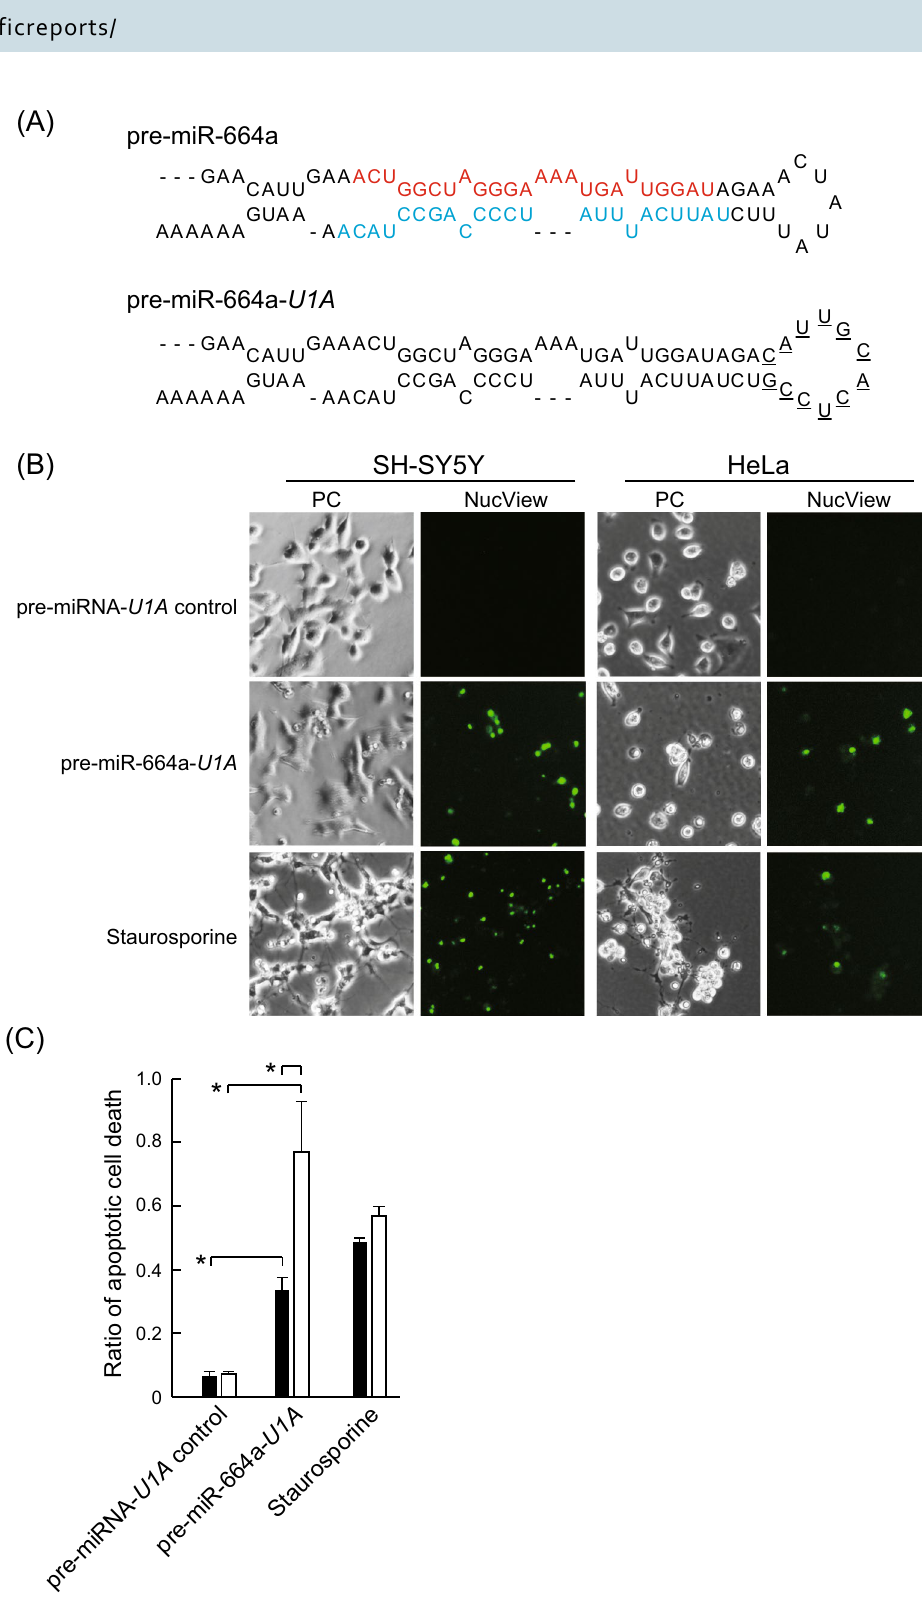
Figure 3. Pre-miR-664a- U1A delivered by lipofection induces apoptosis. ( A ) The pre-miR-664a and pre-miR-664a- U1A sequences are shown. The underlined sequence shown in pre-miR-664a- U1A is replaced with the U1A binding sequence. The red font sequence indicates miR-664a-5p. The light blue font sequence indicates miR-664a-3p. ( B ) SH-SY5Y and HeLa cells were transfected with pre-miRNA- U1A control or pre-miR-664a- U1A using Lipofectamine 3000. Apoptotic cells were detected using NucView 488 caspase assay kit. Staurosporine was used as a positive control. PC phase contrast images. Scale bars indicate 100 µm. ( C ) Apoptosis efficiency of SH-SY5Y (black bar) and HeLa cells (white bar). The data represent the means ± SEM of five independent experiments. *P < 0.01; P-values were calculated using two-way ANOVA and Tukey’s multiple comparisons